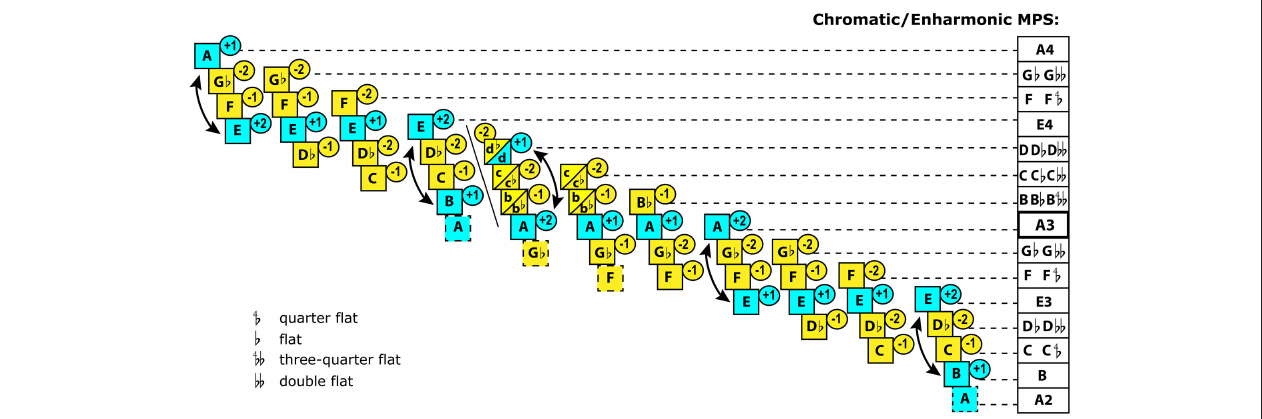
Figure 4 | Chromaitc system according to Cleonides (Aristoxenian school), c.1st century BC. This system contains 11 subsets based on rotation of fixed diatonic tetrachords. Blue color marks the permanent degrees that were associated with stability. Yellow color marks the mutable degrees that required resolution. The tonal tension rating, marked in the circles, is my estimation based on Beliayev’s method 40 . Mese (A3) is assigned greater stability in tetrachords with two stable tones whose “tonic”/“dominant” interaction is marked by an arrow. E3 and E4 are assigned greater stability than the marginal stable tones (B & A4). Of the two unstable tones, the upper one always involves alteration, whereas the lower one retains its “diatonic” state in the chromatic genus—suggesting subordination of the upper tone to the lower one. The black diagonal line marks diezeuxis —the break between the tetrachord meson (E3-A3) and tetrachord diezeugmenon (B3-E4). This break leaves no common tones between these tetrachords in the chromatic/enharmonic genera (B-C-Db-E vs. A-Bb-Cb-D). In order to enable a smooth melodic transition across diezeuxis , Cleonides reserves three pentachords at strategic points (A-B-C-Db-E, Gb-A-B-C-E, and F-Gb-A-B-C), which significantly complicates the Systema Teleion (which engages two upper tetrachords, B-E and E-A) as well as the Systema Metabolon (which, instead, terminates the MPS at D with the tetrachord synemmenon A-Bb-C-D). The lowest pentachord adds a stand-alone A2 in order to accomplish the A/E modal framework. The chart reflects the chromatic genus. The column on the right summarizes the pitch values for the chromatic as well as enharmonic genera of the unstable tones. The enharmonic genus can be told by the quarter-flat, three-quarter-flat, and double-flat alteration signs. The entire MPS reveals a centripetal tendency, where the greatest variability in pitch occurs next to the central Mesa (A3). The entire system is characterized by extreme gravitational diversity : altogether there are 6 types of distribution of gravity within a modal